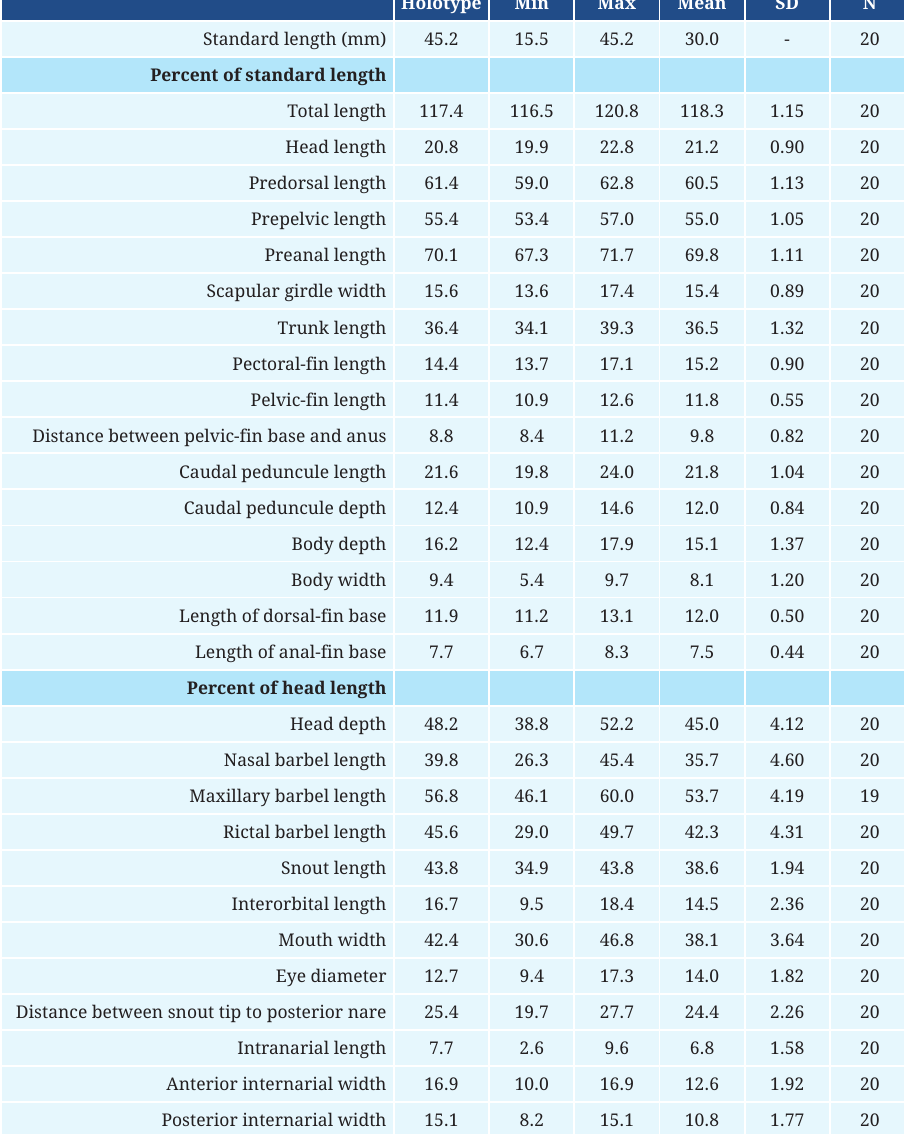
TABLE 10 | Morphometric data of Scleronema teiniagua , new species (data of holotype included in the range). N = number of specimens; SD = standard